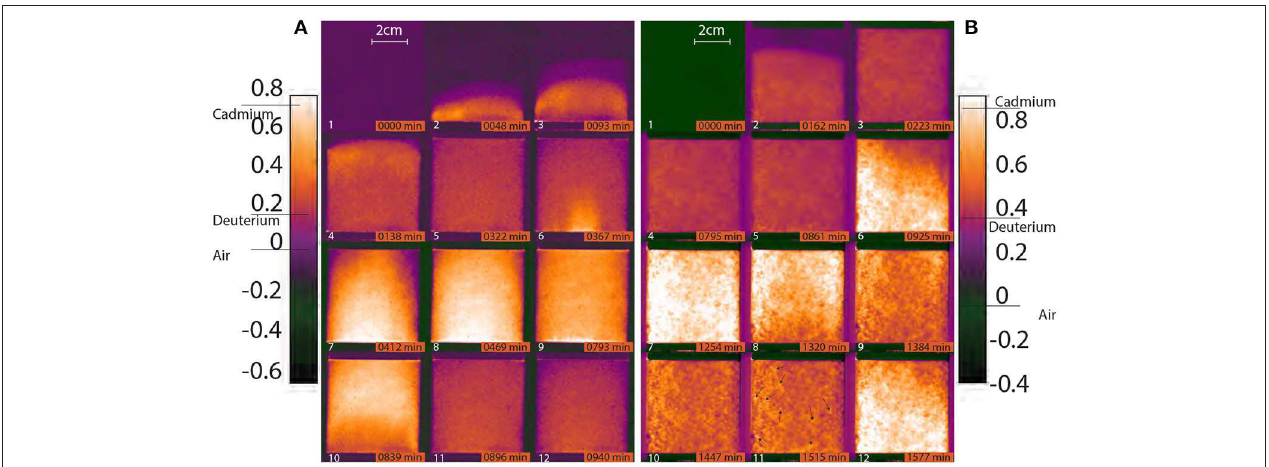
FIGURE 4 | Time-lapse 2D radiographs of injection of cadmium in (A) Fontainebleau sandstone and (B) Indiana limestone. The first injection of D 2 O was followed by an injection of D 2 O +Cd. Samples were then washed with a second injection of D 2 O. For the limestone only, a second injection of D 2 O+Cd has been performed at the end of the experiment. The color code shows the range expected for air, D 2 O, and D 2 O+Cd. Black arrows in slide 11, (B) , evidence the spots where “unwashed” cadmium is maximum. Note, however, that comparing slide 11 and 5, most of the sample contains some unwashed cadmium.